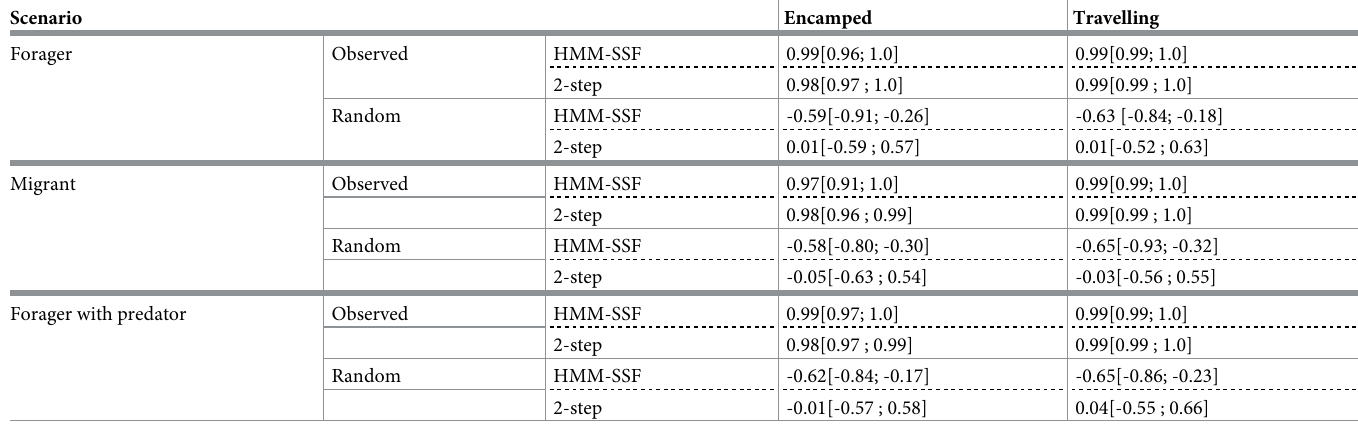
Table 1. Assessment of the HMM-SSF predictive capability in comparison to a 2-step approach from simulations based on state-specific step selection functions, to predict habitat selection along encamped and travelling movement in three ecological scenarios, using k -fold cross validation. Means, minimums and maximums ([min; max]) of 100 Spearman rank correlation are reported for each movement mode and both observed and random steps. Scenario Encamped Travelling